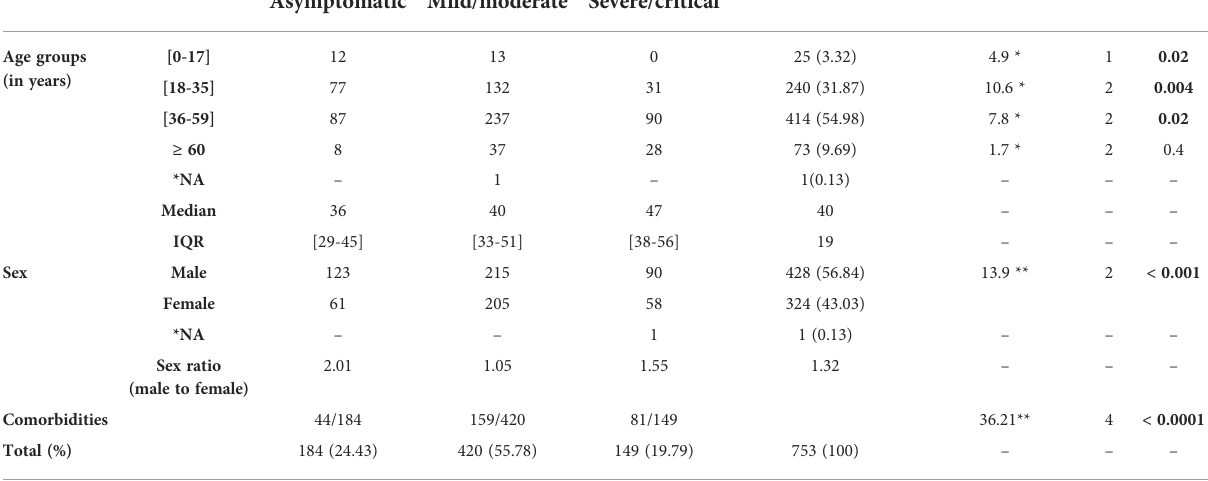
TABLE 1 COVID-19 patients ’ age, sex, and comorbidities distribution rate according to the clinical status.